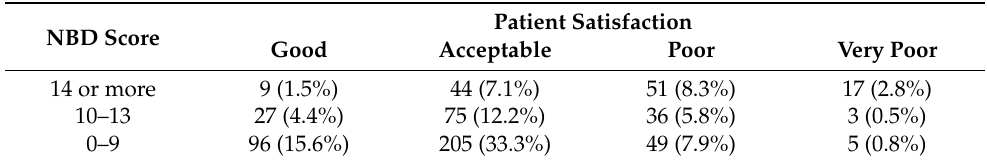
Table 3. Distribution of responses according to the NBD score and patient satisfaction before adjusting for special attention